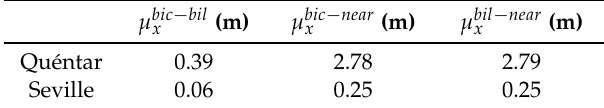
Table 3. Mean absolute differences between interpolation methods to resample the ICA DEM.